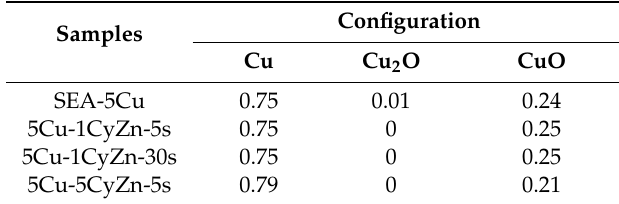
Figure 8. Experimental XANES spectra registered the Cu K-edge of reduced SEA-5Cu and ZnO over-coated Cu / SiO 2 catalysts ( left ). The first derivative XANES spectra ( right ). Table 5. Cu species in the reduced SEA-5Cu and ZnO over-coated Cu / SiO 2 catalysts based on linear combination fitting.